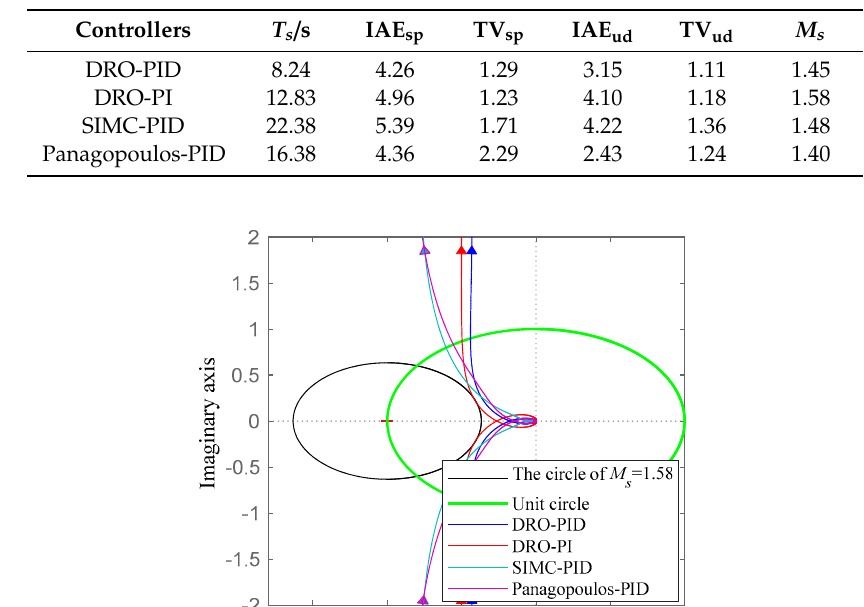
Table 3. The indices of Example 1 with different controllers.